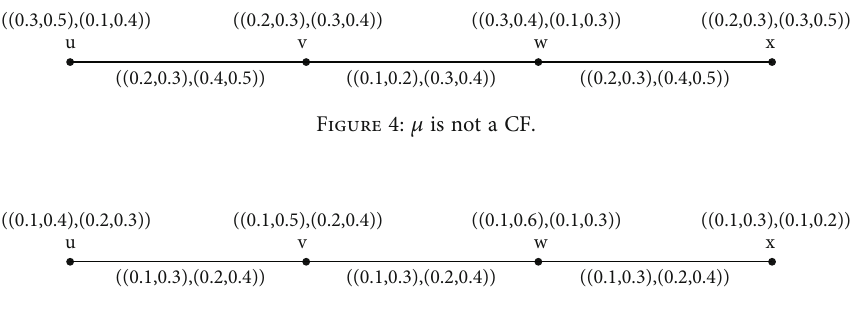
Figure 5: G is both NEI-IVIFG and NETI-IVIFG, not SI-IVIFG.